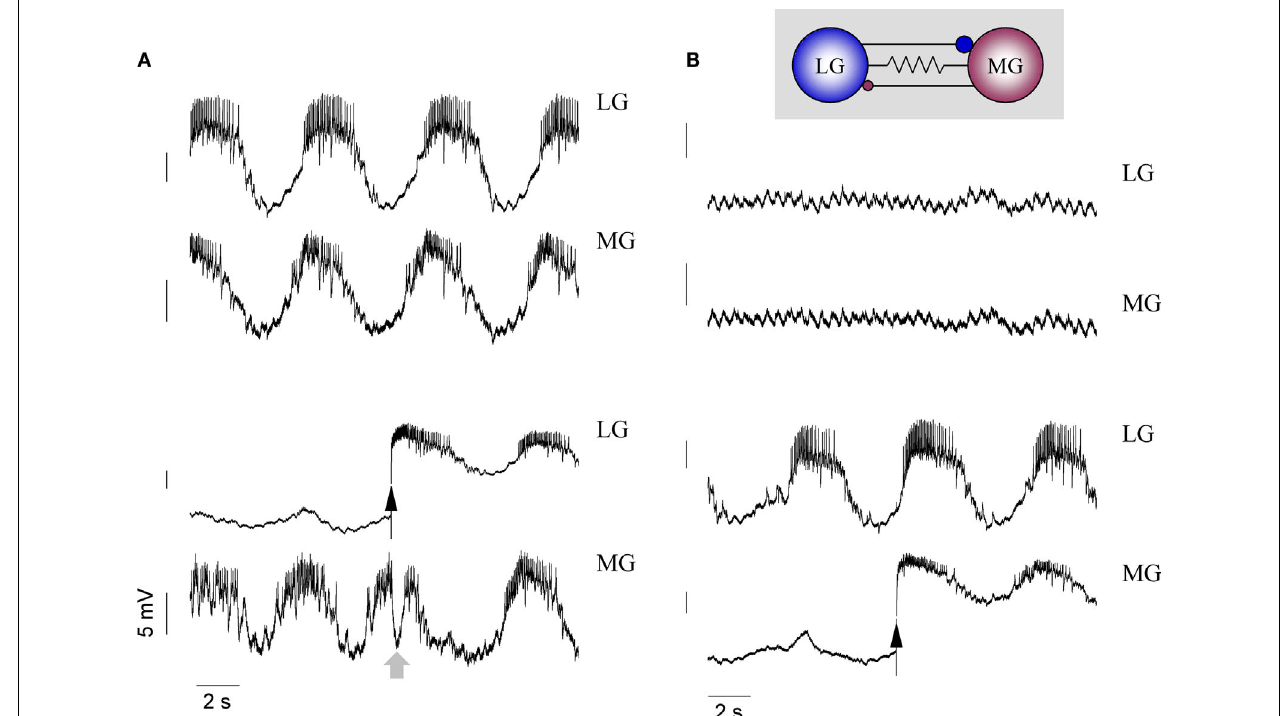
FIGURE 7 | Interactions between the LG and MG neurons. In normal conditions, the two neurons burst in-phase with MG slightly ahead of the LG (A) . When both neurons are hyperpolarized, the gastric rhythm even in the rest of the network is greatly diminished and the membrane potential traces of both LG and MG become fl at (apart from the 2 Hz pyloric modulation) (B) . Releasing